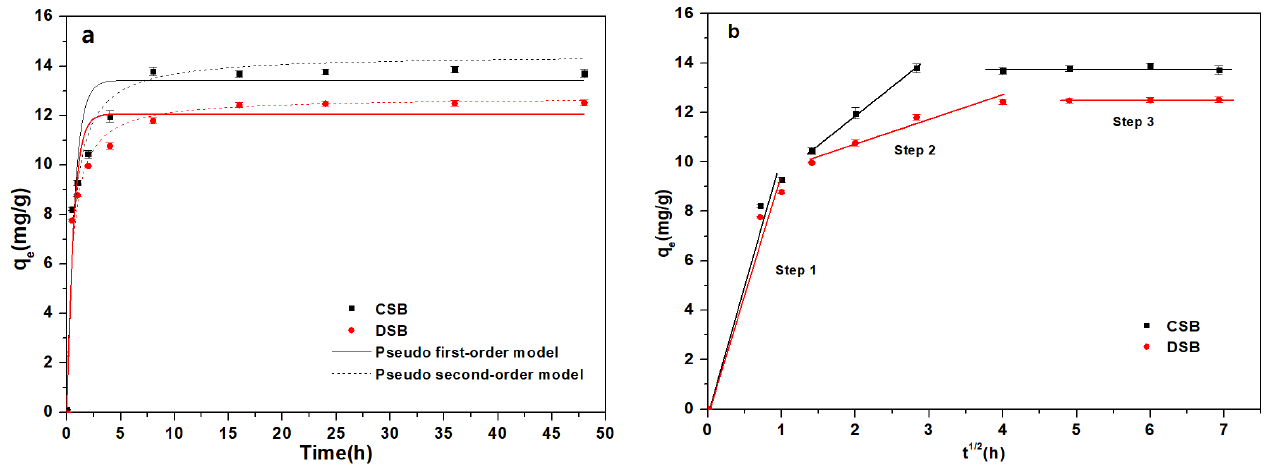
Figure 2. ( a ) Kinetics of 17 β -estradiol (E2) onto corn straw and dewatered sludge biochars (CSB and DSB). The dotted line is the pseudo-first-order model, and the solid line is the pseudo-second-order model; ( b ) intraparticle diffusion model for the E2 adsorption on CSB and DSB.